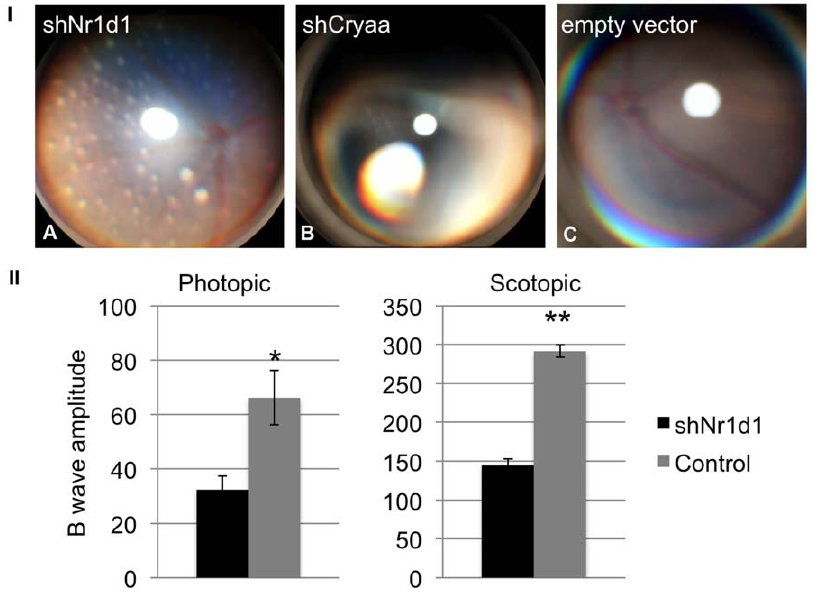
Figure 3. Injection with shNr1d1 results in pan-retinal spotting and reduced response to light in scotopic (dark-adapted) and photopic (light-adapted) experiments. Mice were injected at postnatal day (P) 0.5 and aged to P30.5 for clinical and functional phenotyping. I: shNr1d1 (A) produced pan-retinal spotting visible on the fundus. Injection with shCryaa (B) resulted in lens opacity. Vector only injections (C) resulted in no visible fundus phenotype. II: Graphic representation of scotopic electroretinogram testing the function of rod cells, and photopic electroretinogram testing the function of cone cells, reveled that shNr1d1 reduced the response to light by 50% compared with controls. Responses from photoreceptor cells and second order neurons were affected. shNr1d1 n=3, B6 control n=5. Statistical significance of a two-tailed unpaired t- test are shown as: *: p , 0.05; **: p , 0.01.